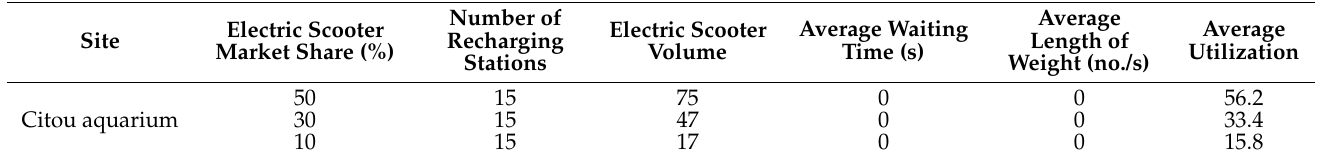
Table 1. Service volume and performance for the allocation of recharging stations (Author’s paper, ([32], p. 5)).